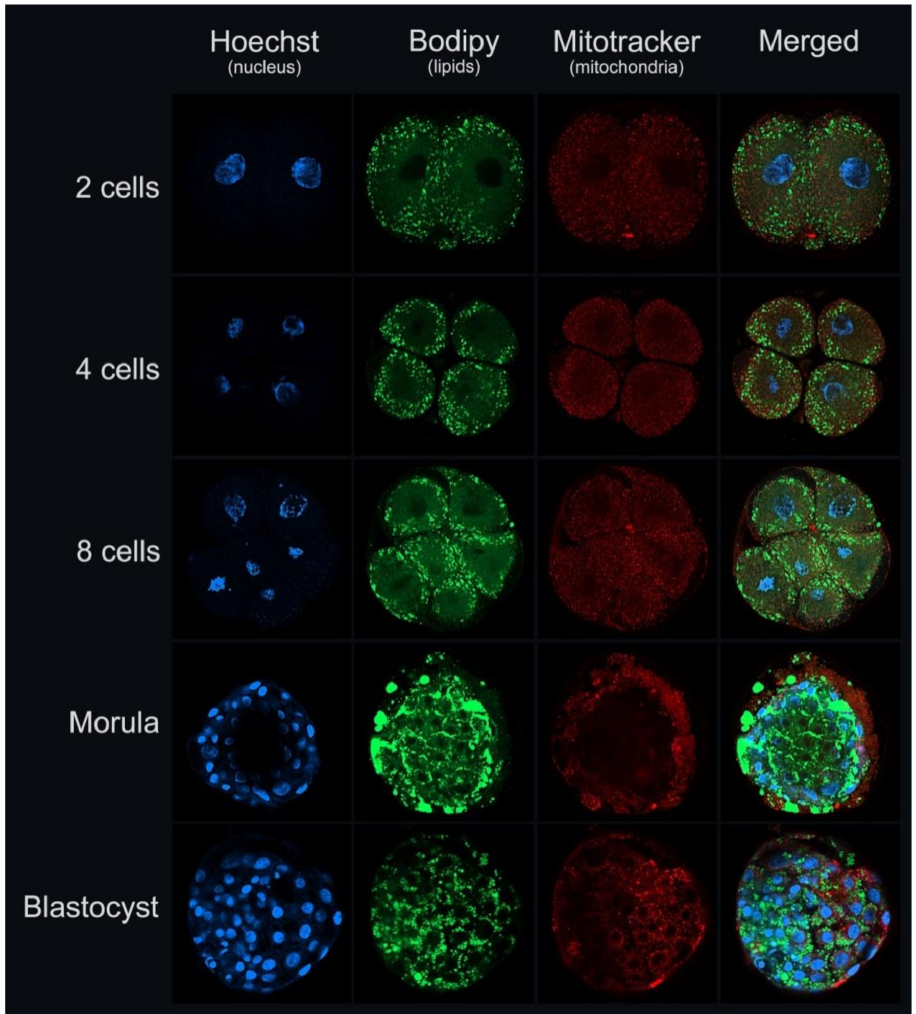
Figure 2. Illustrative images of bovine embryos during in vitro culture (2, 4, 8 cell stage, morula, and blastocyst), demonstrating cell number (nucleus staining, Hoechst 33,342–blue; Sigma-Aldrich, Merck KgaA, Darmstadt, Germany), lipid content (Bodipy 493/503–green; Molecular Probes, Eugene, OR, EUA), and mitochondrial activity (MitoTracker ® Orange–red; Molecular Probes, Eugene, OR, EUA) (vital staining, confocal laser scanning microscopy, Cardoso/Pöhland/Melo-Sterza,